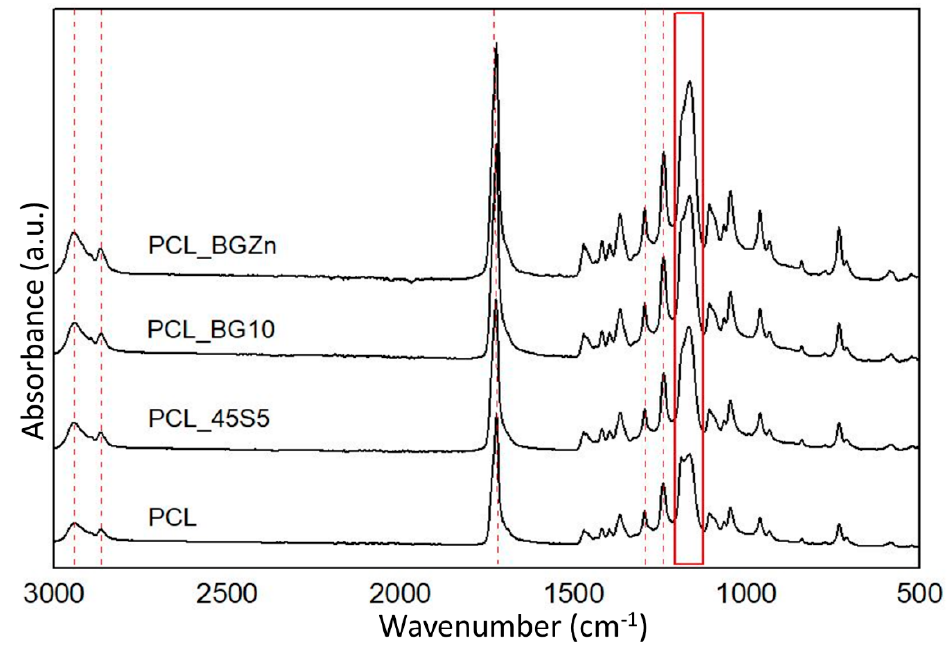
Figure 4. FTIR spectra of PCL, PCL_45S5, PCL_BG10, and PCL_BGZn electrospun mats before immersion in SBF solution. The indicated peaks are discussed in the text.